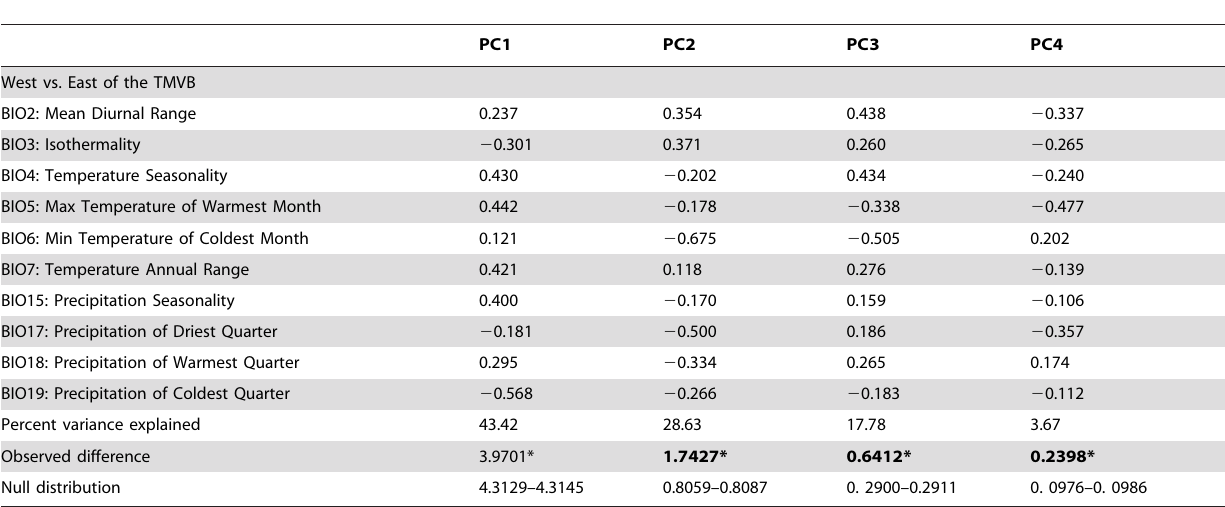
Table 3. Loadings of the environmental variables for each PC axis and tests of niche divergence and